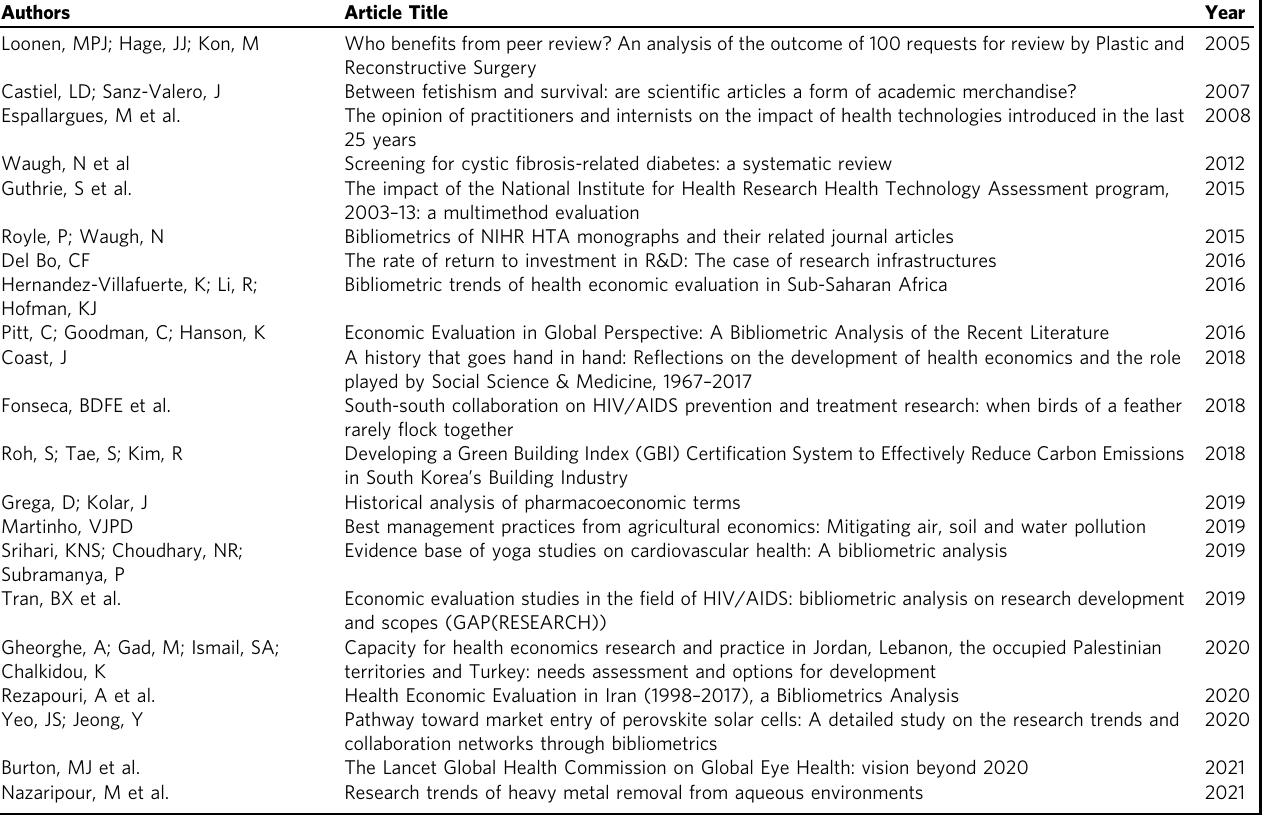
Table 1 Bibliometric studies on the effectiveness of Cost in the health sector during the period 2005 –